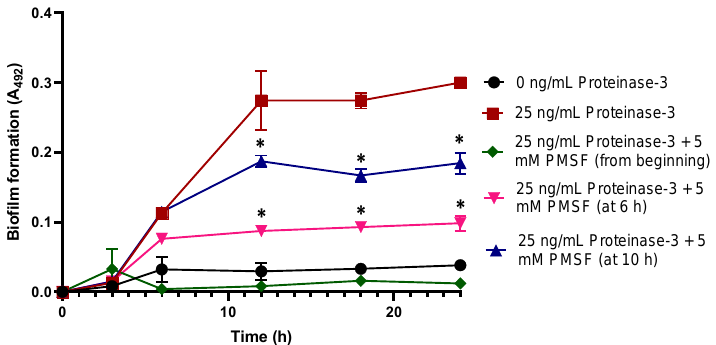
8 of 20 Figure 4. Proteinase-3 addition at different stages of biofilm formation. Biofilm forming kinetics of a commensal (HS, healthy skin, panel ( A )) and a clinical (OI, ocular infection, panel ( B )) non-biofilm- forming isolate was done in the presence of proteinase-3 added at 6 or 10 h. The abundance of bio- film was determined according to Christensen et al. sampling at different points of the kinetics. Asterisk * indicates a significant difference ( p < 0.05) concerning the bacteria with proteinase-3 since the beginning of the culture. The statistical analysis was performed using a one-way ANOVA with